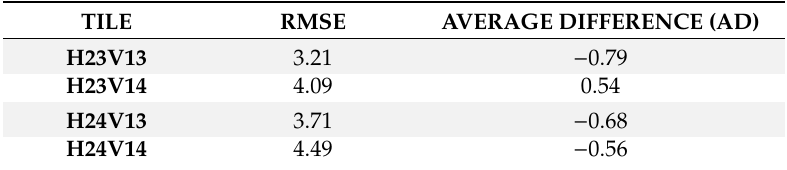
Figure 6. Model-estimated land surface temperature compared to the Landsat observations for four tiles in Atlanta, GA. The color suggests the standard deviation of predictions through iterations. Table 1. Root Mean Square Error (RMSE) and average di ff erence (observed minus predicted) of land Table 1. Root Mean Square Error (RMSE) and average difference (observed minus predicted) of land surface temperature (Kelvin) for four tiles in Atlanta, surface temperature (Kelvin) for four tiles in Atlanta, Georgia.